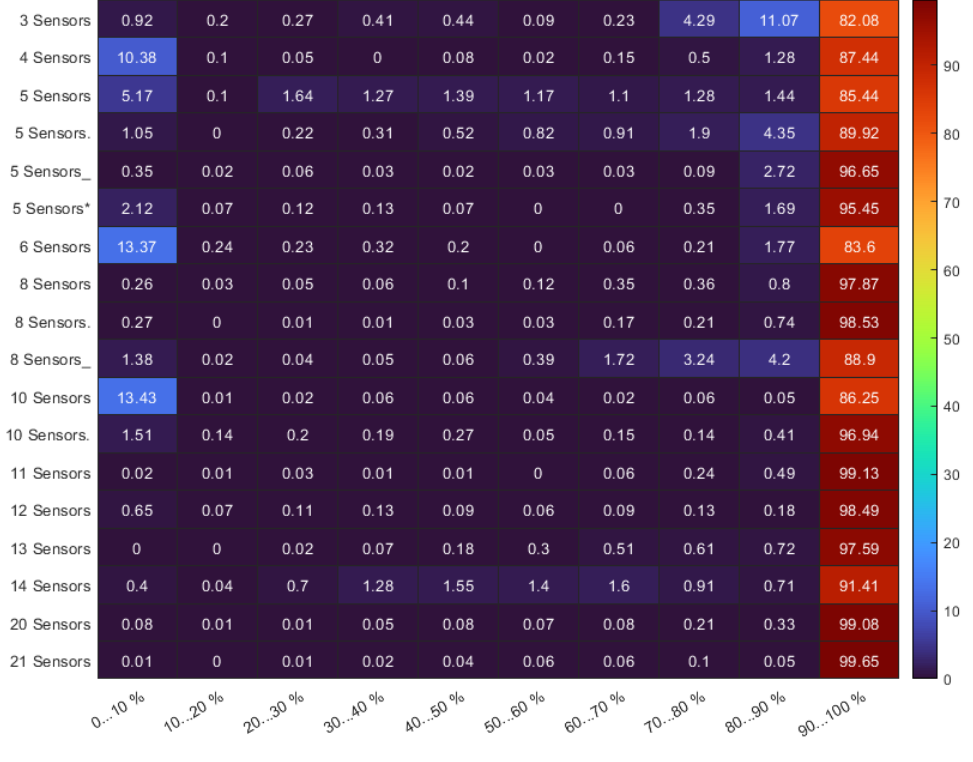
Figure 22. The detection probability distribution for different arrangements and sensor